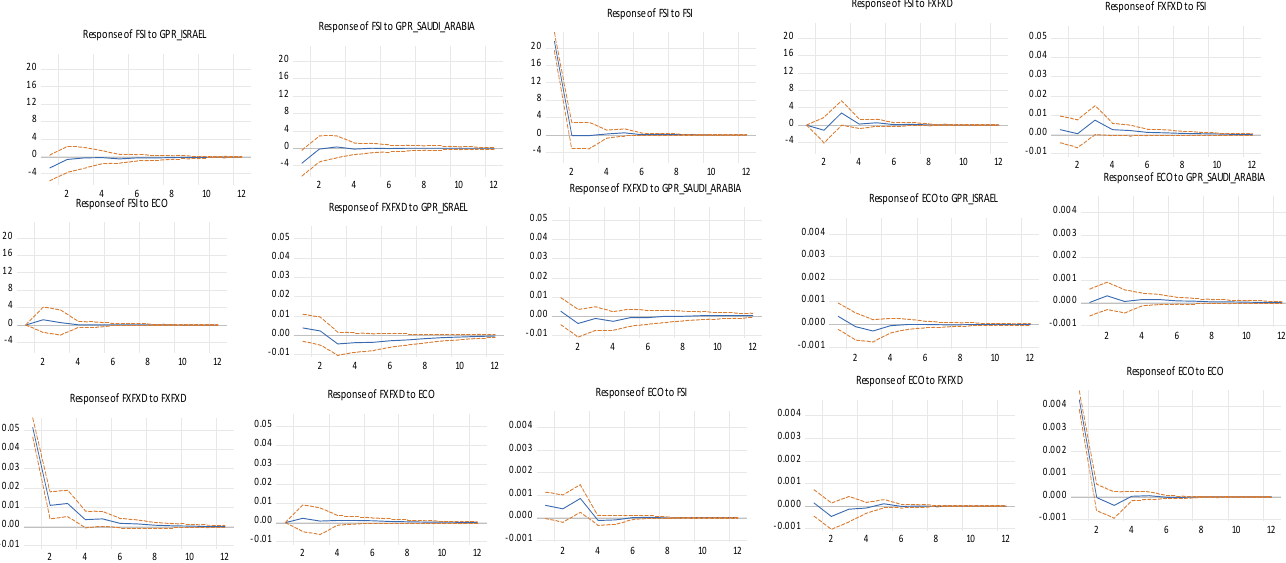
Figure A1. Impulse response functions.